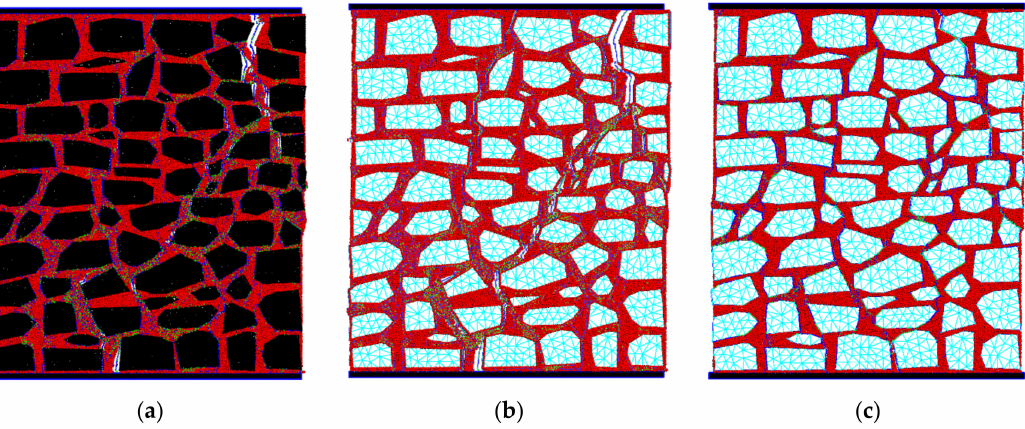
Figure 15. Final crack patterns for uniaxial compression testing in rubble wall: ( a ) DEM; ( b ) H-FEM- DEM-A; ( c ) H-FEM-DEM-B [15].